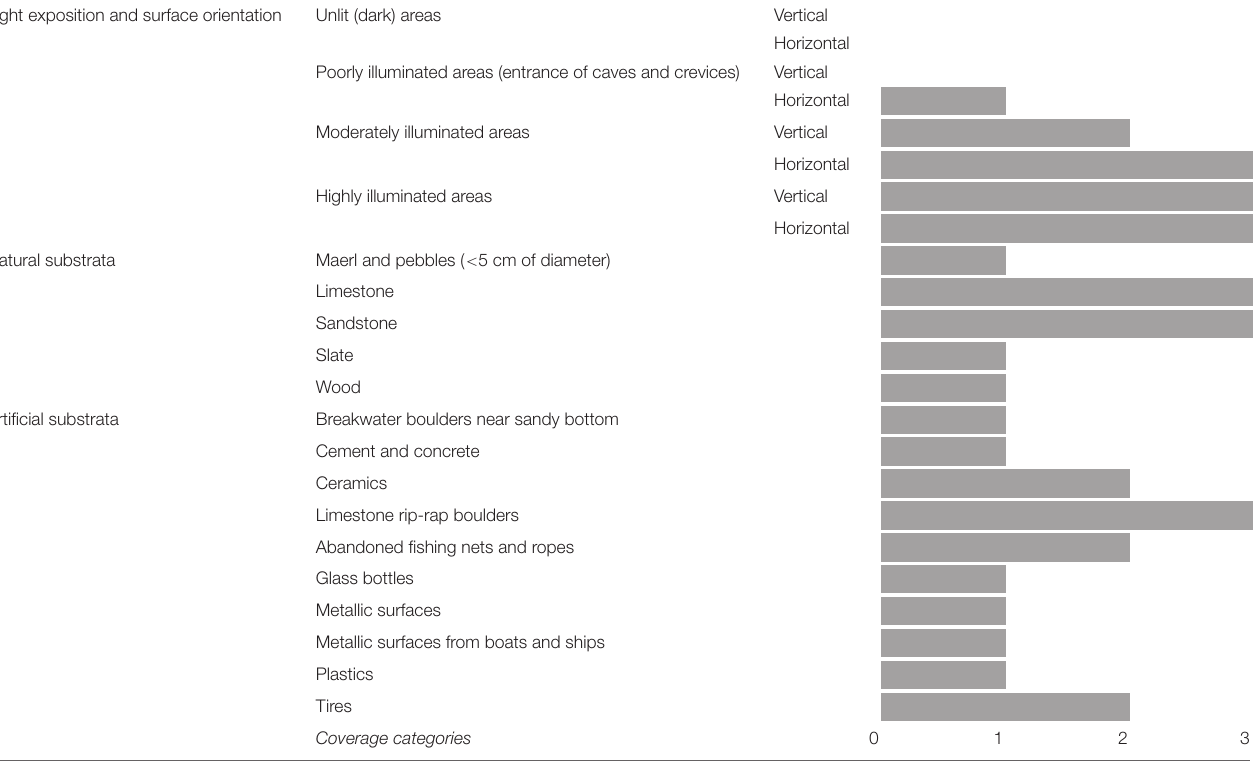
TABLE 1 | Coverage of Rugulopteryx okamurae under different lighting conditions and substrata nature (natural and artificial substrata). Light exposition and surface